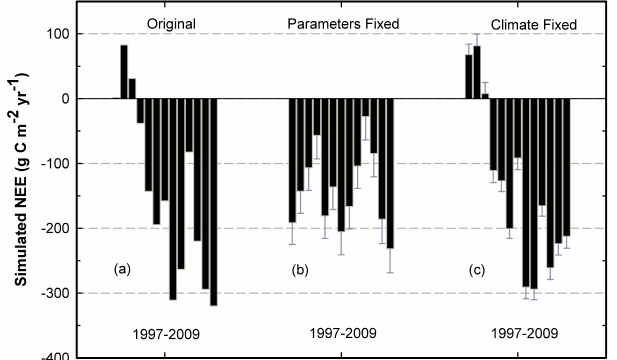
Fig. 6. Interannual variation in simulated NEE (a) NEE original : us- ing the original climate and parameter time series in each of the 13yr; (b) NEE parfix : parameters kept constant; (c) NEE clifix : cli- mate kept constant. Each value of NEE parfix and NEE clifix rep- resents an ensemble mean value of the 13 simulations where the parameter, or climate time series from 1997–2009 was applied in sequence. The error bars show the standard error.